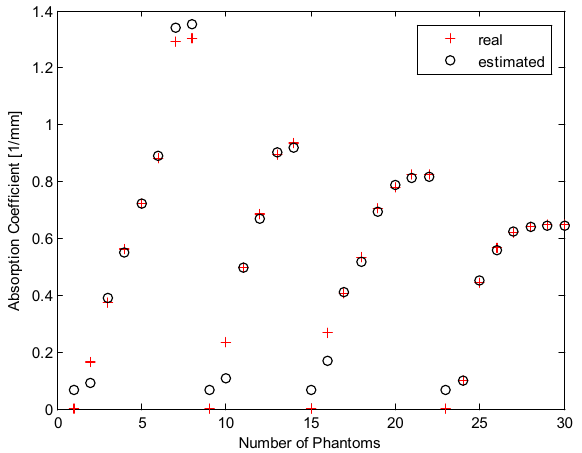
Fig. 7. Estimation of (cid:1) a using MC simulation-based di®use